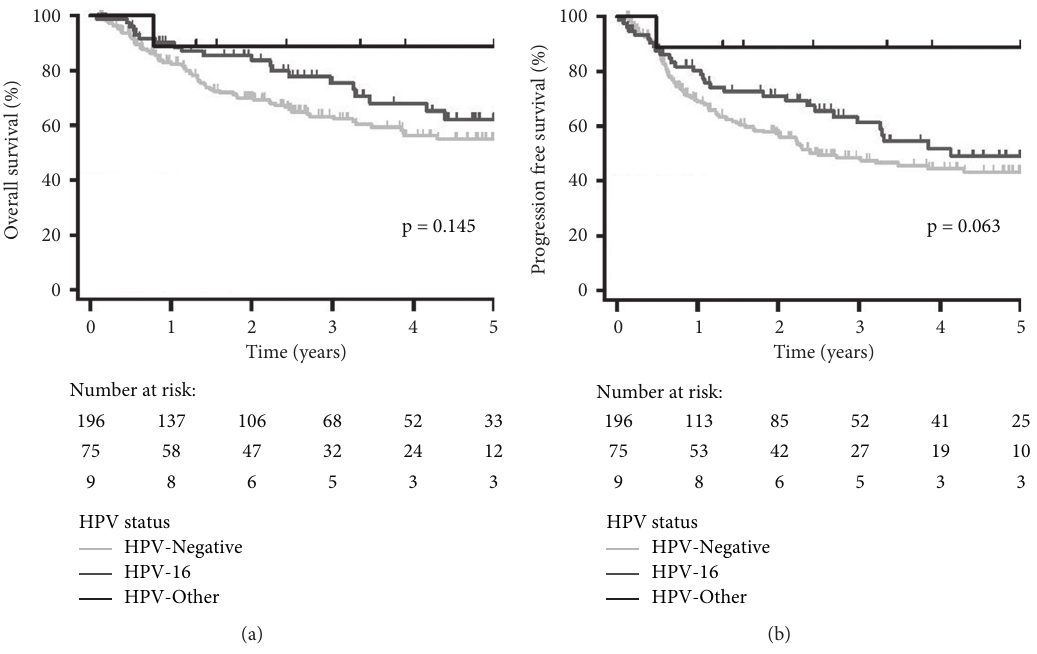
Figure 2: Kaplan–Meier plots stratified by HPV status (HPV-16 vs. HPV-other vs. HPV-negative) for (a) overall survival and (b) progression-free survival for all patients ( n �